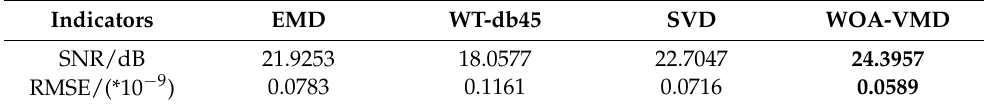
Table 3. Comparison results of denoising indicators when SNRin = 15